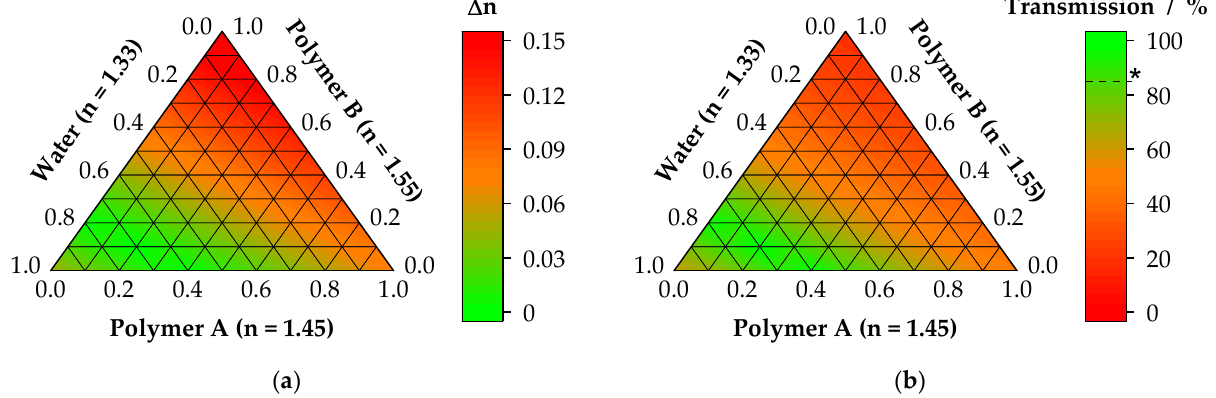
Figure 9. Example for a mixture of two polymers and different water uptake after swelling. From the refractive indices of the single materials, the overall refractive index as well as the difference with respect to the refractive index of the cornea can be calculated ( a ). Using Equation (11), the resulting light transmission through such hypothetic scaffolds can be estimated ( b ). Scaffold was defined to be 10 µm thick, consisting of fibers with a fiber diameter, after swelling, of 100 nm. Transmission is shown at 589 nm. Asterisk (*) indicates corneal transparency corresponding to T cornea > 85%.